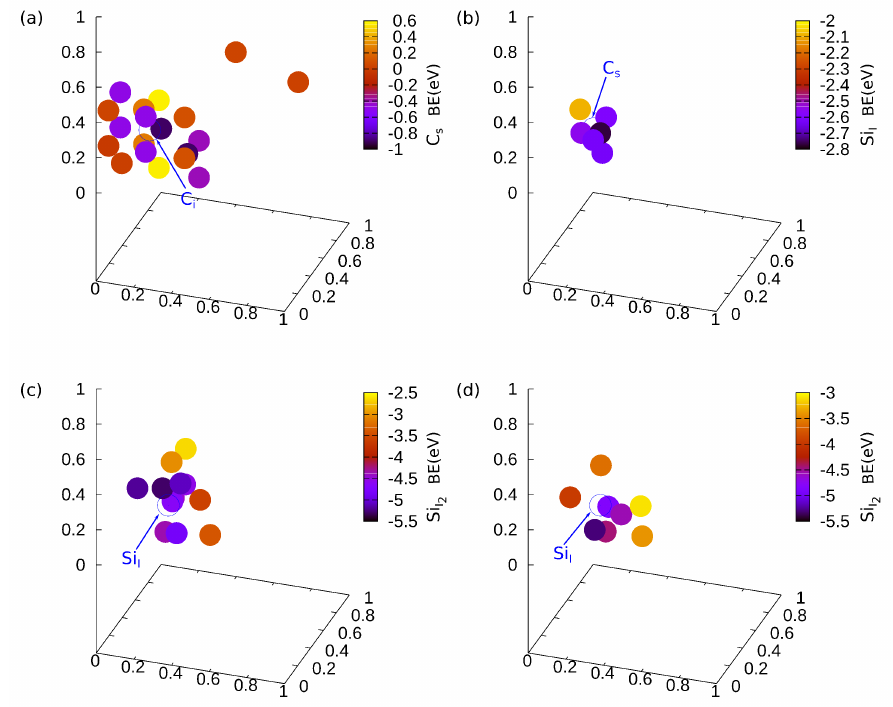
Figure 1. Relative positions of the defects with the lowest binding energy ( a ) of the possible C s substitutional and the C i interstitial defect, ( b ) of the “first in order” possible Si interstitial (Si I ) and the chosen C s substitutional defects, ( c ) of the “second in order” possible Si interstitial (Si I2 ) and the chosen “first in order” most favourable Si interstitial (Si I ), and ( d ) of the “second in order” possible Si interstitial (Si I2 ) and the chosen “first in order” second favourable Si interstitial (Si I ). The blue circle denotes the position of the “given” interstitial and the color bar represents the binding energy for each